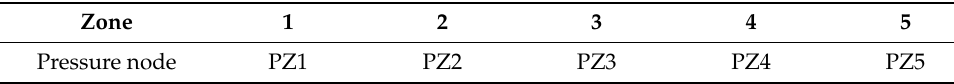
Table 3. Pressure observation nodes (positions are given in Figure 2).